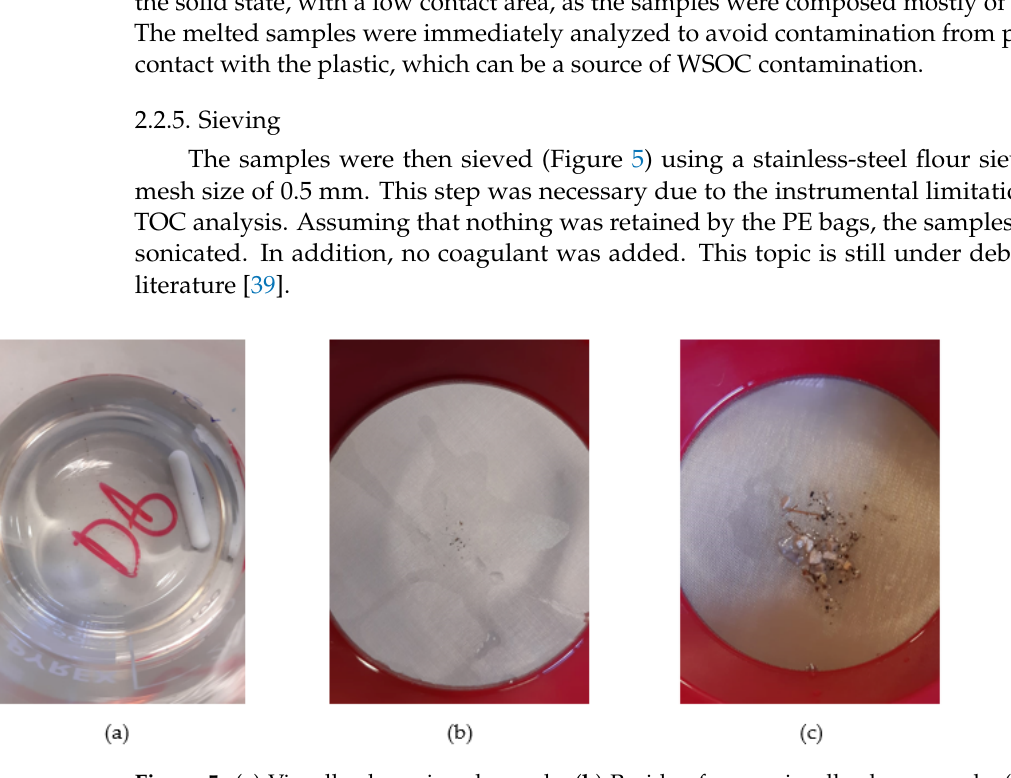
Figure 5. ( a ) Visually clean sieved sample; ( b ) Residue from a visually clean sample; ( c ) Residue collected after sieving sample P4.